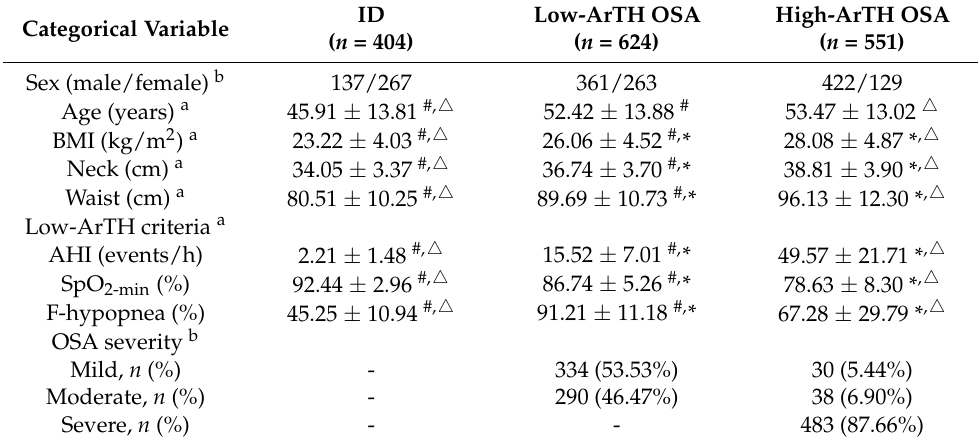
Table 1. Demographic characteristics of the participants grouped by arousal threshold criteria. Categorical